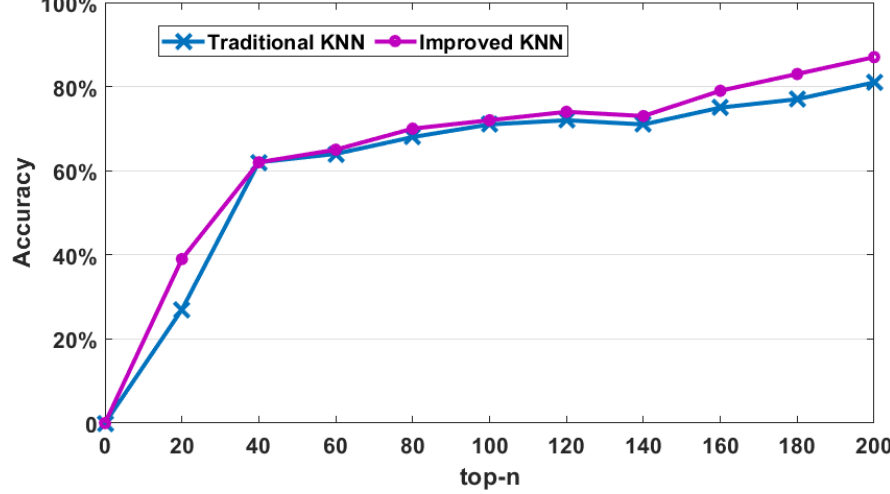
Figure 8. Accuracy rate variation.